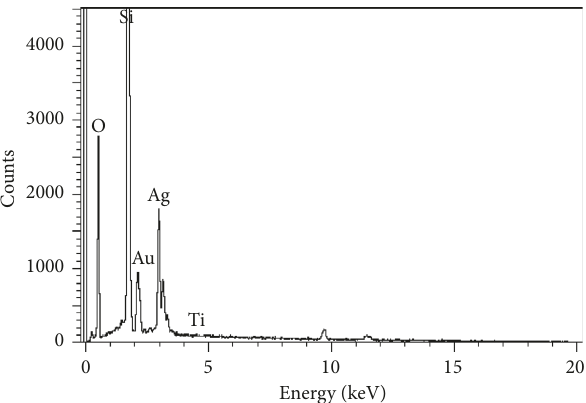
Figure 7: EDX result from zone 2 of the sample at 1200 ° C growth temperature and 6hours baking time.